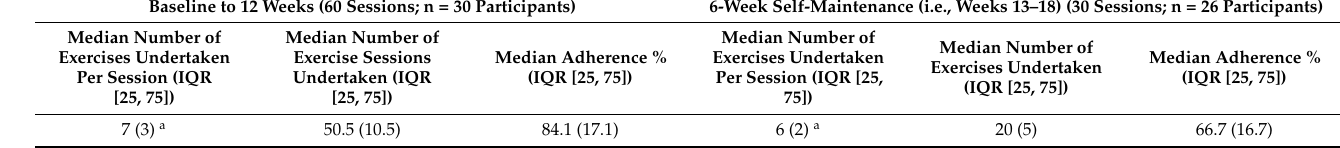
Table 3. Number of exercises and number of exercise sessions undertaken and median adherence (%) to 12 weeks with physiotherapist’s supervision and 6-week self-maintenance (i.e., weeks 13–18) phase of the exercise